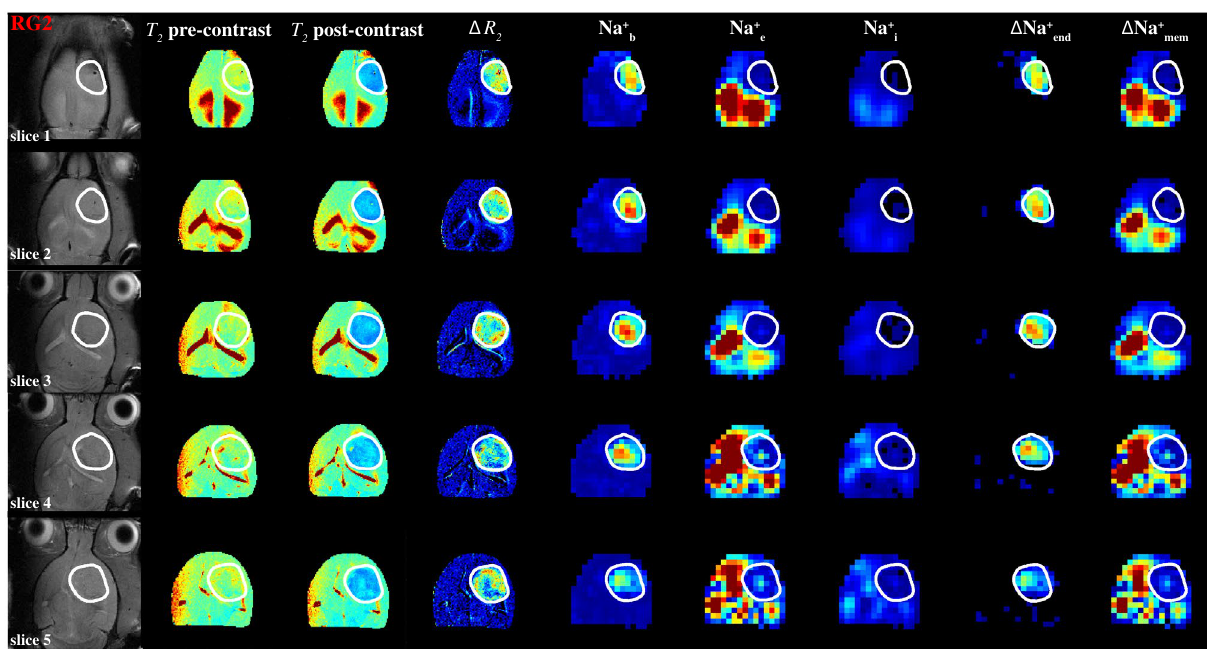
Figure 4. Spatial distributions of compartmentalized 23 Na signals (Na + b , Na + e , Na + i ) as well as transendothelial (ΔNa + end ) and transmembrane (ΔNa + mem ) gradients in an RG2 tumor. The high-resolution 1 H-MRI data are shown in the left four columns, whereas the lower resolution 23 Na-MRSI data are shown in the next five columns on the right. The left column shows the tumor location (white outline) on the anatomical 1 H-MRI (left), whereas the next two columns show the T 2 maps (range shown: 0–100 ms) before and after TmDOTP 5− injection, and the subsequent column depicts the ∆ R 2 map (i.e., difference between 1/T 2 maps before and after, range shown: 0–30 s −1 ), which is proportional to [TmDOTP 5- ] in healthy and tumor tissues. Since ∆ R 2 values are more heterogeneous within the tumor, the 23 Na-MRSI data are needed to separate the blood and extracellular compartment signals for the tumor. Since the integral of each 23 Na peak represents the [Na + ], the respective three columns show the integral maps of Na + b , Na + e , and Na + i from left to right (i.e., ∫ Na + b , ∫ Na + e , ∫ Na + i ). The last two columns on the right show ΔNa + end = ∫ Na + b - ∫ Na + e and ΔNa + mem = ∫ Na + e - ∫ Na + i . The ∫ Na + b map reveals low values in healthy tissue compared to tumor tissue, and within the tumor boundary a high degree of heterogeneity. The ∫ Na + e map reveals low values in tumor and normal tissues, but within the tumor boundary a small degree of heterogeneity is visible while ventricular voxels show very high values. The ∫ Na + i map reveals low values ubiquitously except some ventricular voxels. The ΔNa + end map reveals dramatically high values within the tumor only. The ΔNa + end was driven primarily by an increase of ∫ Na + b inside the tumor and which was more pronounced in superficial regions of the brain compared to deeper slices. The ΔNa + mem map shows low values in tumor tissue compared to normal tissue, although ventricular voxels show very high values. The ΔNa + mem is driven primarily by decreased ∫ Na + e and thus shows similar level of heterogeneity as the ∫ Na + e map. All maps use the same color scale and are relative. See Figure S4 for an example for a U87